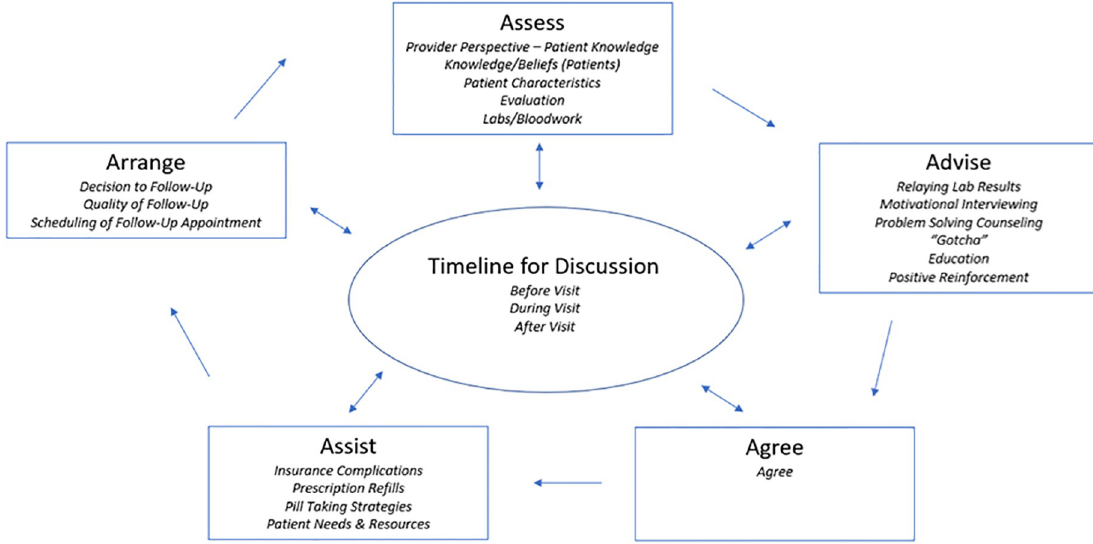
Fig 1. Adapted 5 A’s model of self-management support with thematic in-depth interview code assignments. Adapted 5 A’s Model of self-management support. The codes used in analysis were tied to the main 5 A’s model parent codes (Assess, Advise, Agree, Assist and Arrange) with the added component of Timeline for Discussion, which was an entirely new parent code with accompanying child